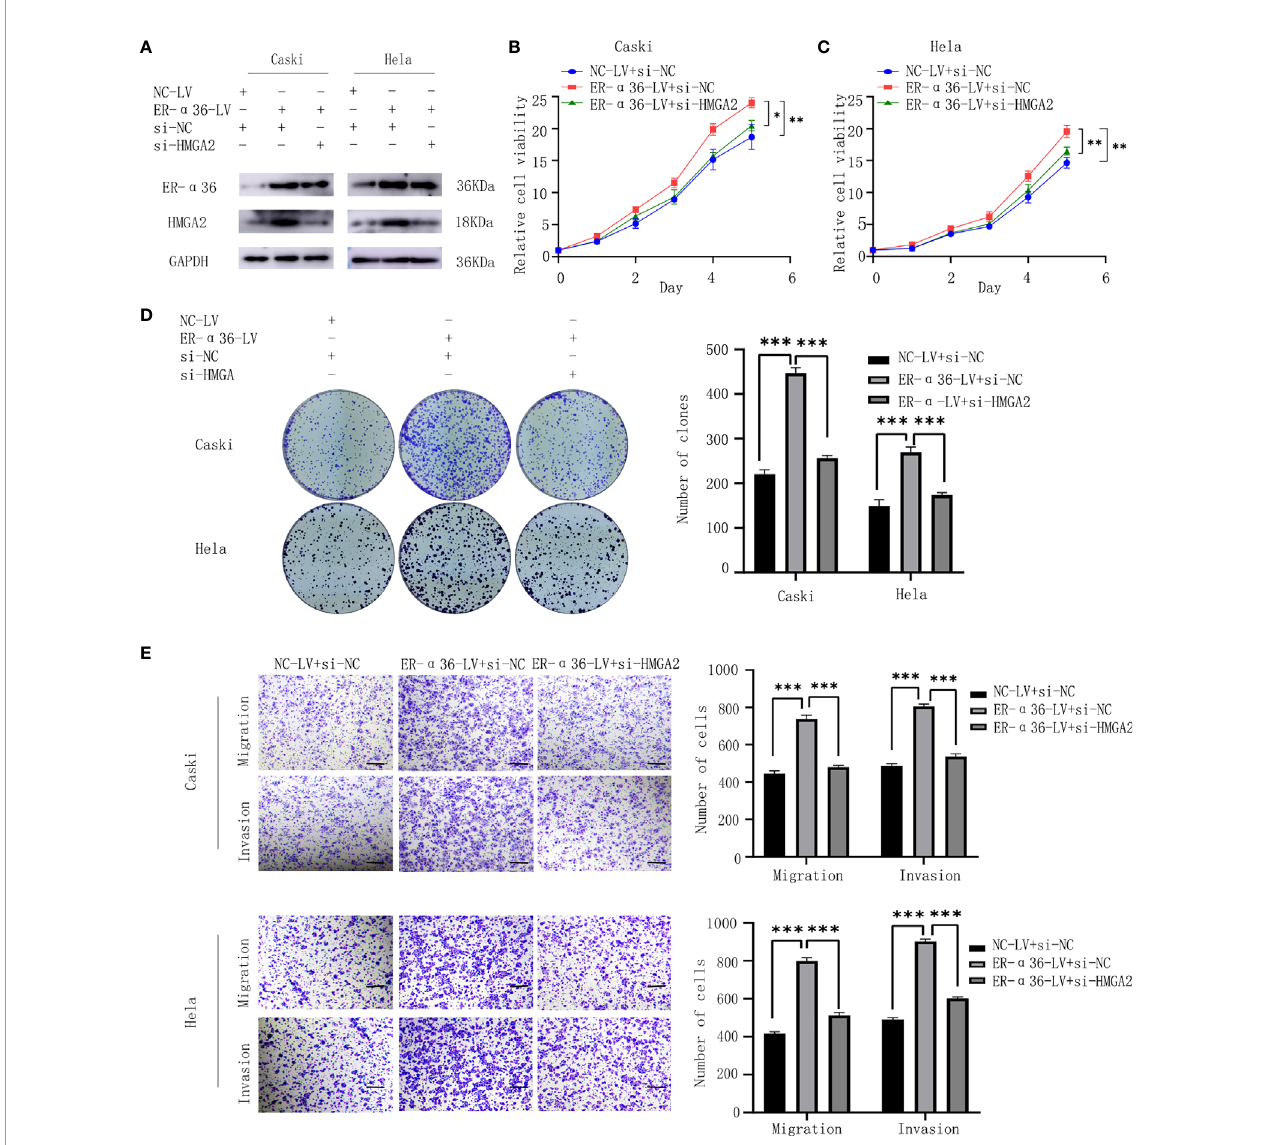
FIGURE 8 | ER- a 36 promotes E 2 -induced malignancy of CC depending on HMGA2. si-HMGA2 and si-NC were introduced into caski and hela cells which were previously transfected with NC-LV or ER- a 36-LV, Cells were treated with 1nM E 2 . (A) Western blotting was used to assess HMGA2 and ER- a 36 expression. Cell proliferation was detected by CCK8 assay (B, C) and colony formation assay (D) . Migration and invasion abilities were examined by transwell assay (E) . Scale bar: 50 m m. (Data are mean ± SEM, *p < 0.05, **p < 0.01, ***p < 0.001, n =